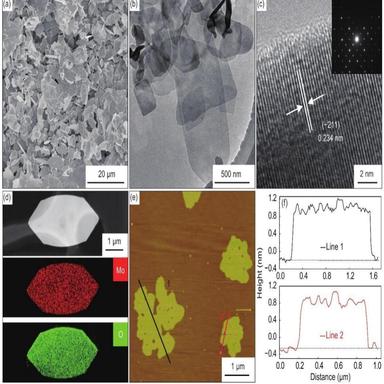
a) SEM image of MoO2 NSs, (b) TEM image of MoO2 NSs, (c) HRTEM image and SAED patterns (insert) of MoO2 NSs, (d) STEM and the corresponding Mo, O mapping images of MoO2 NSs, (e) AFM image of MoO2 NSs and (f) the height profiles corresponding to the solid lines in AFM image.